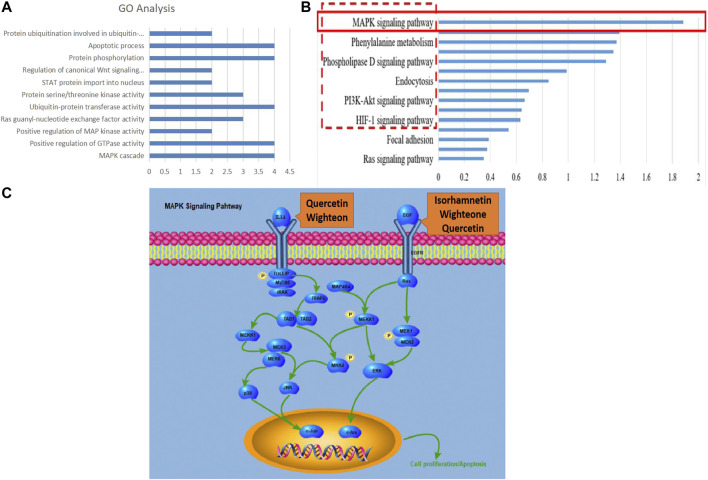
GO and pathway enrichment analysis and components-targets pathways process of BSJPJDD therapy. (A) enriched GO, (B) enriched signaling pathways, (C) components -targets-pathways-process.